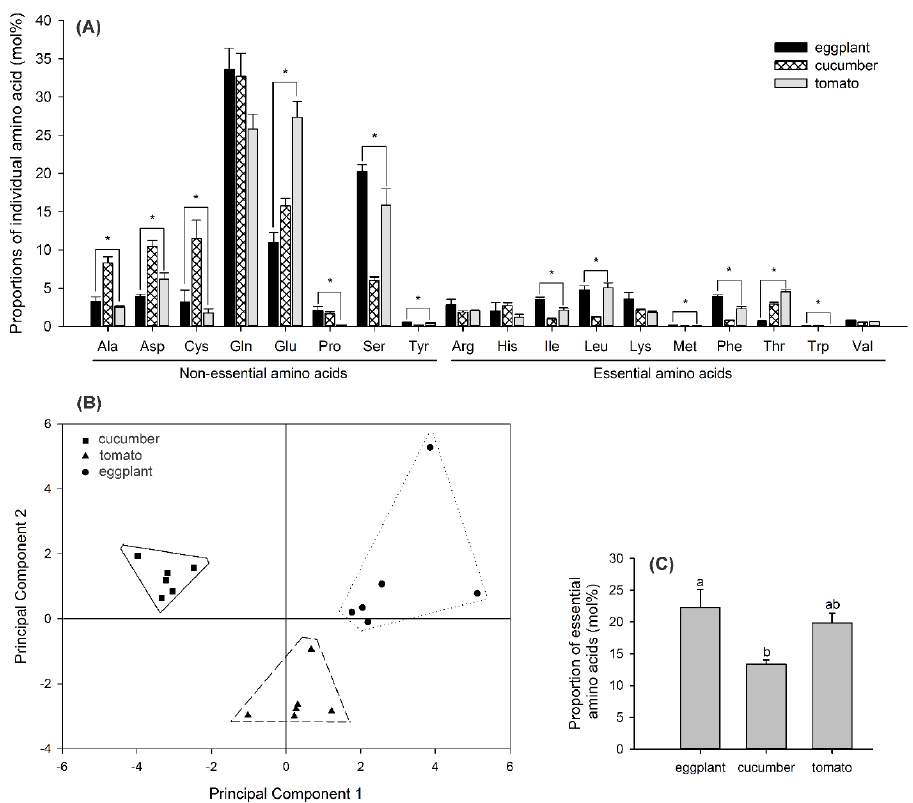
Figure 5. Proportions of individual amino acids (mean ± SE) (mol%; A ), amino acid–composition analysis by principle component analysis (PCA) ( B ), and percentage of the entire essential amino acids (EAAs) in the phloem sap of eggplant, cucumber, and tomato leaves (mol%; C ). Non-EAAs: Ala, alanine; Asp, aspartic acid; Cys, cysteine; Gln, glutamine; Glu, glutamic acid; Pro, proline; Ser, serine; and Tyr, tyrosine. EAAs: Arg, arginine; His, histidine; Ile, isoleucine; Leu, leucine; Lys, lysine; Met, methionine; Phe, phenylalanine; Thr, threonine; Trp, tryptophan; and Val, valine. Asterisk or di ff erent letters above the error bars indicate significant di ff erences in individual amino acids or percentage of the entire EAAs among the three plant species ( p < 0.05, Tukey’s HSD test). Table 4. Statistical analyses of individual amino acids detected from plant phloem sap and from whitefly